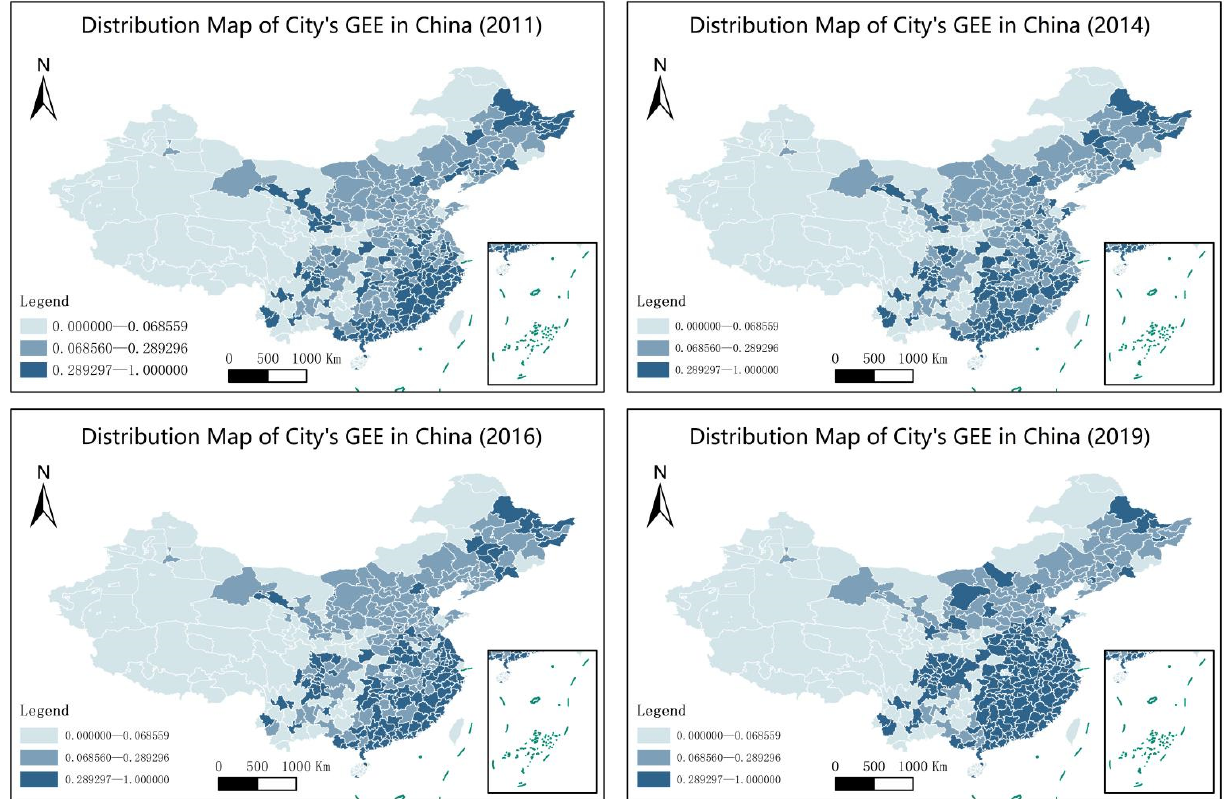
Figure 1. Geographical distribution map of city’s GEE in China (2011–2019).